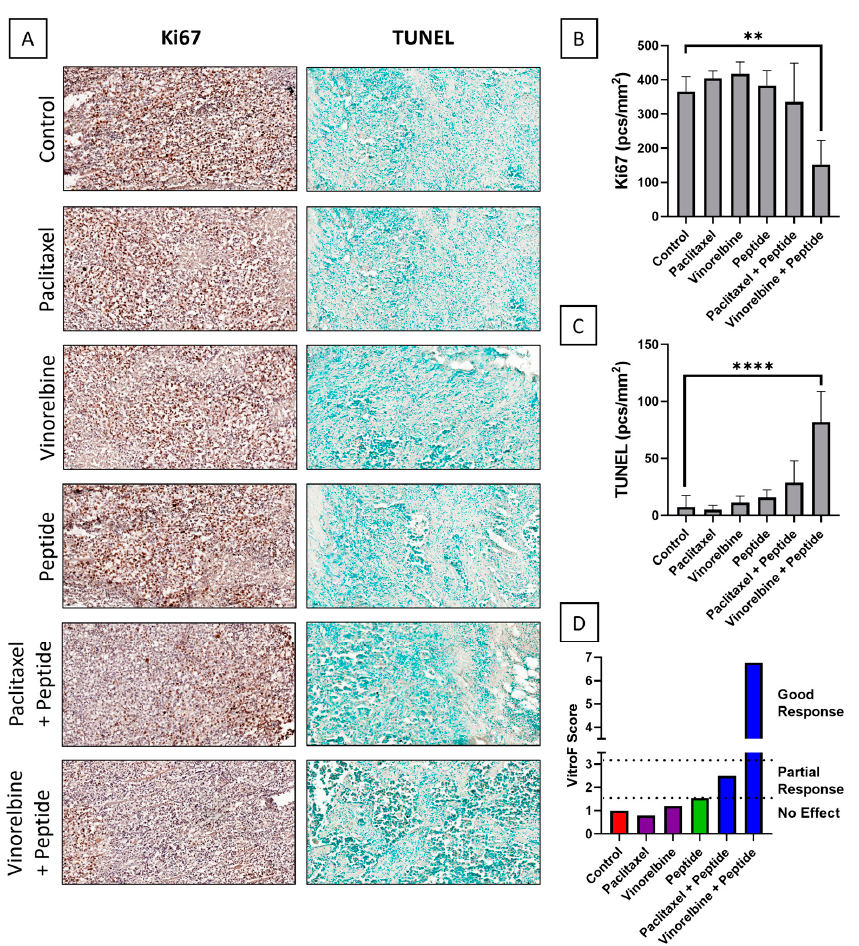
Figure 3. IHC staining of tissue explants of Patient #3 after ex vivo single and combinatorial drug treatment with paclitaxel, vinorelbine and R11-NLS-Pep8. ( A ) Representative images of control and treated explants showing cell proliferation marker, Ki67 and TUNEL assay (20× magnification, 100 µm scale-bar). Quantification of ( B ) Ki67 and ( C ) TUNEL positive cells of control and treated explants, expressed as object frequency (pcs/mm 2 ). Graphs representing mean ± SEM. ** p < 0.01 & **** p < 0.0001 with ordinary one-way ANOVA multiple comparisons test, is significantly different from Control. ( D ) VitroF score of the treatments. 2.2. Patient Tumors Show Variable Degree of PD-L1 and Surface PCNA Expression When subjected to flow cytometric analysis, the cells derived from the patients’ tu-